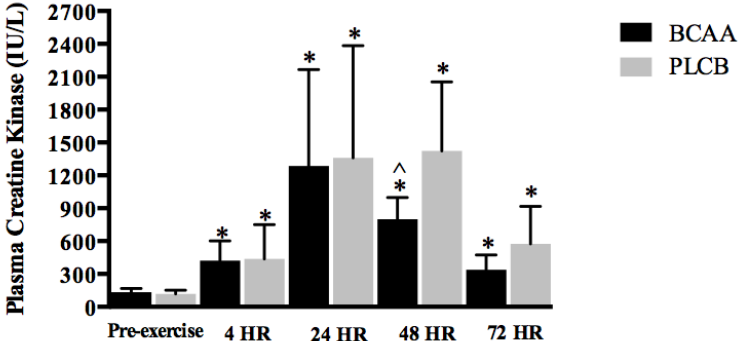
Figure 6. Mean ( ± standard deviation) plasma creatine kinase (IU/L; international units per liter) pre-eccentric exercise, 4, 24, 48 and 72 hours (HR) for resistance trained men supplementing with branched-chain amino acids (BCAA) or placebo (PLCB) ( n = 20). * = significantly different from pre-exercise ( p < 0.001); ^ = significantly different from PLCB group ( p = 0.02).